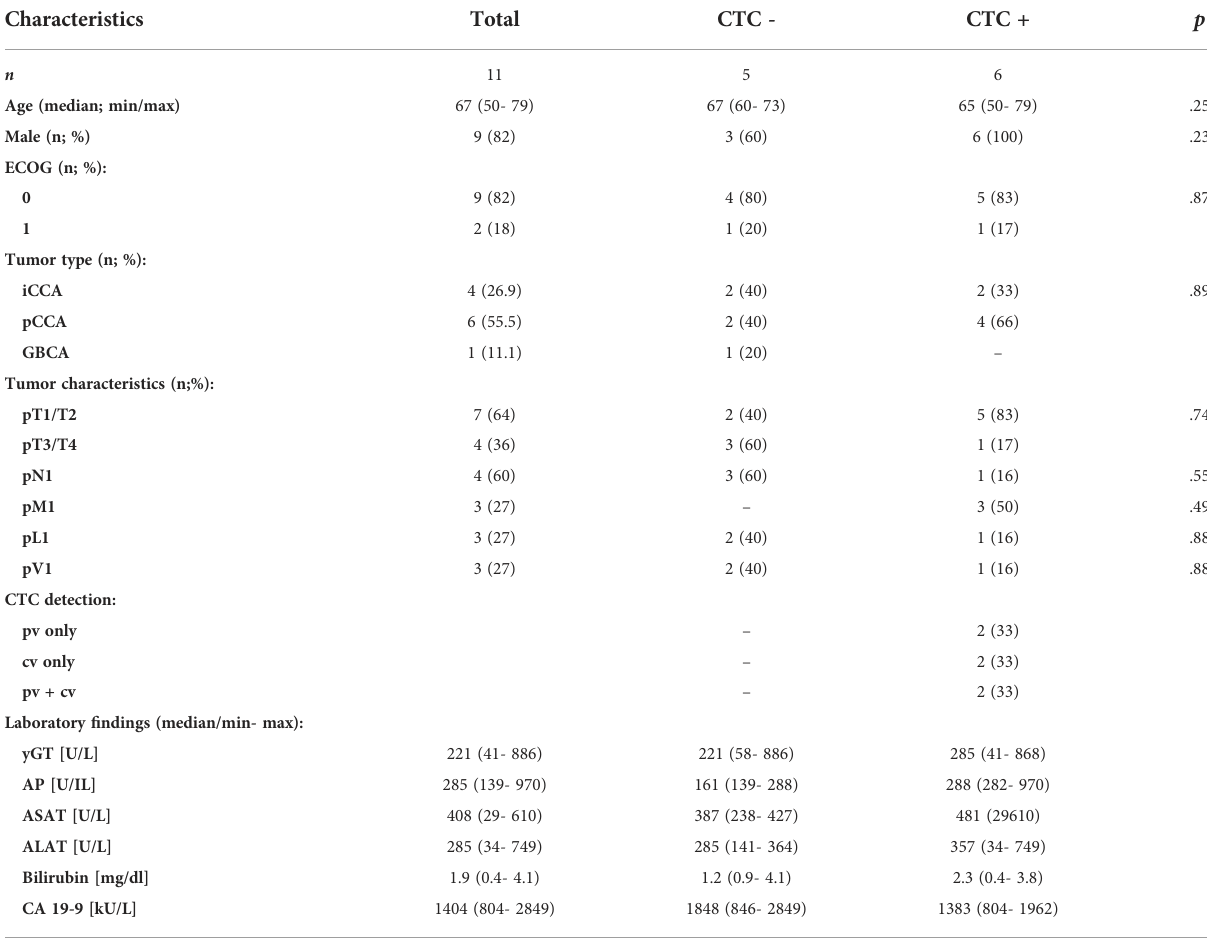
TABLE 2 Baseline characteristics of the resection